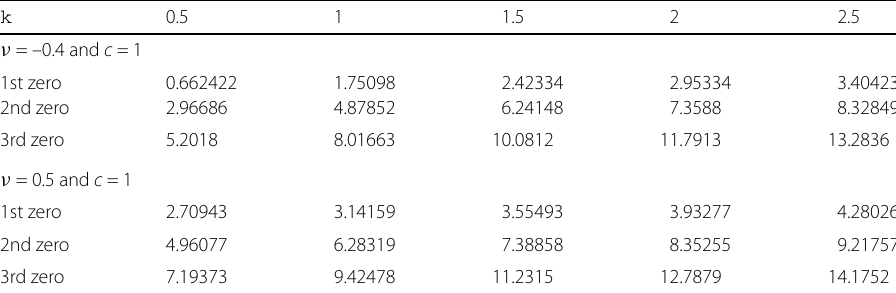
Table 1 Positive zeroes of W k ν